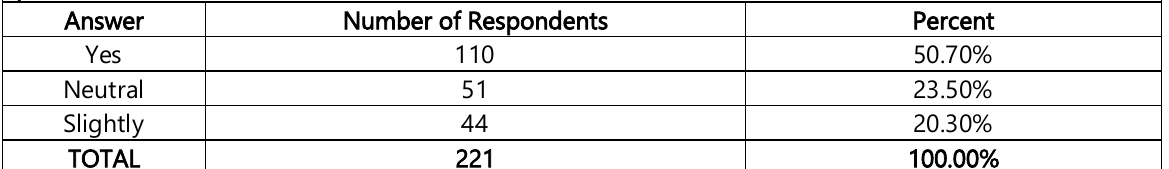
Table 5: Reflection of the Perception of the Level of Readiness of Businesses/Persons to Commit Fiscal Evasion (Source: Authors’